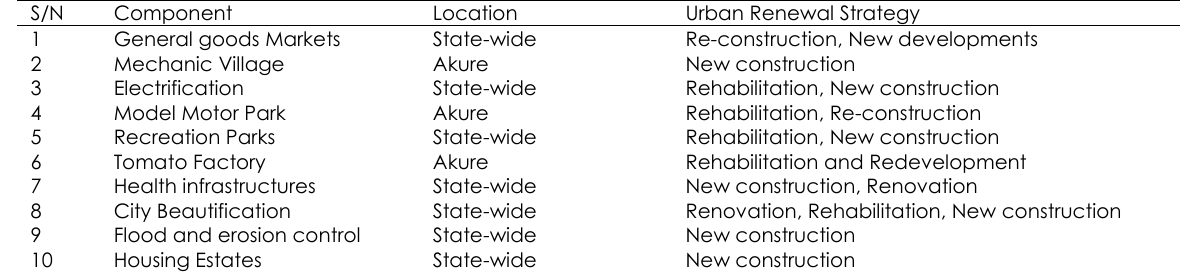
Table 1. Summary of urban renewal products in Ondo State, Nigeria. S/N